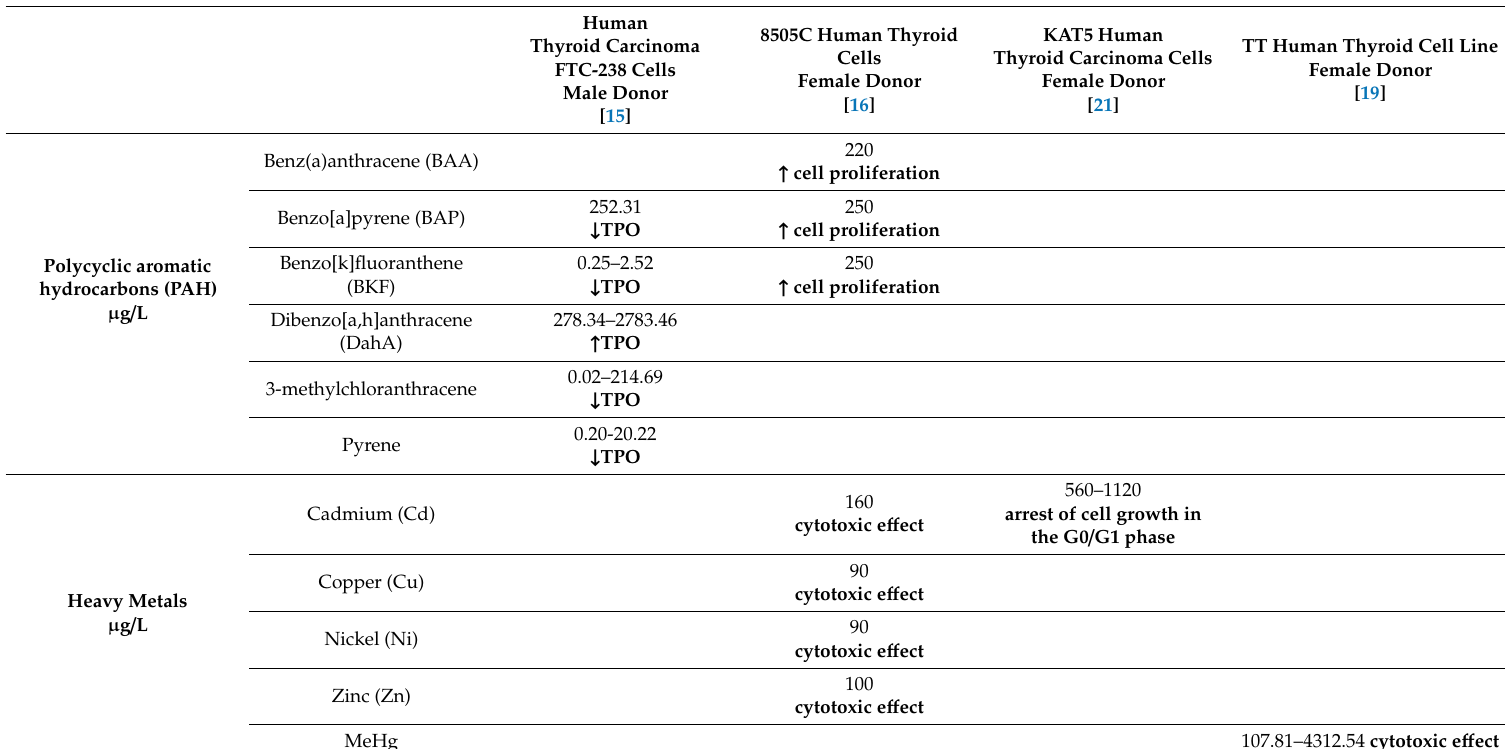
Table 1. Doses of EDs normalized to the same unit of measurement and their e ff ects on human thyroid cell